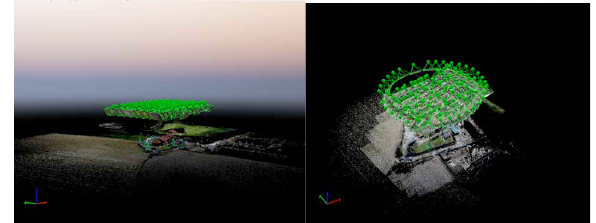
Figure 8. Cameras position estimated by Pix4D in two of the considered datasets (Mavic Pro left and Phantom 4 Pro Right) The results of the test performed with Pix4D on the different combinations of dataset are reported in the following Tables 1- 2. The result connected to Configuration D (only nadir acquisition) is reported in the last page of the paper.